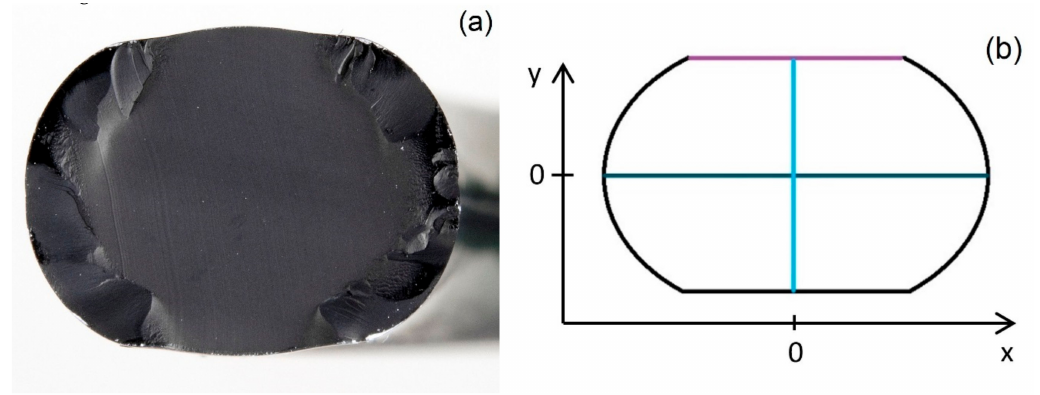
Figure 10. ( a ) Photo of the cut cross-section of an HNBR O-ring with compression set and DLO e ff ects aged for 101 days at 150 ◦ C. ( b ) Drawing of the cross-section of an O-ring with compression set. The colored lines represent the respective measurement lines for the indenter modulus measurements shown in Figure 11 and Figure 13.